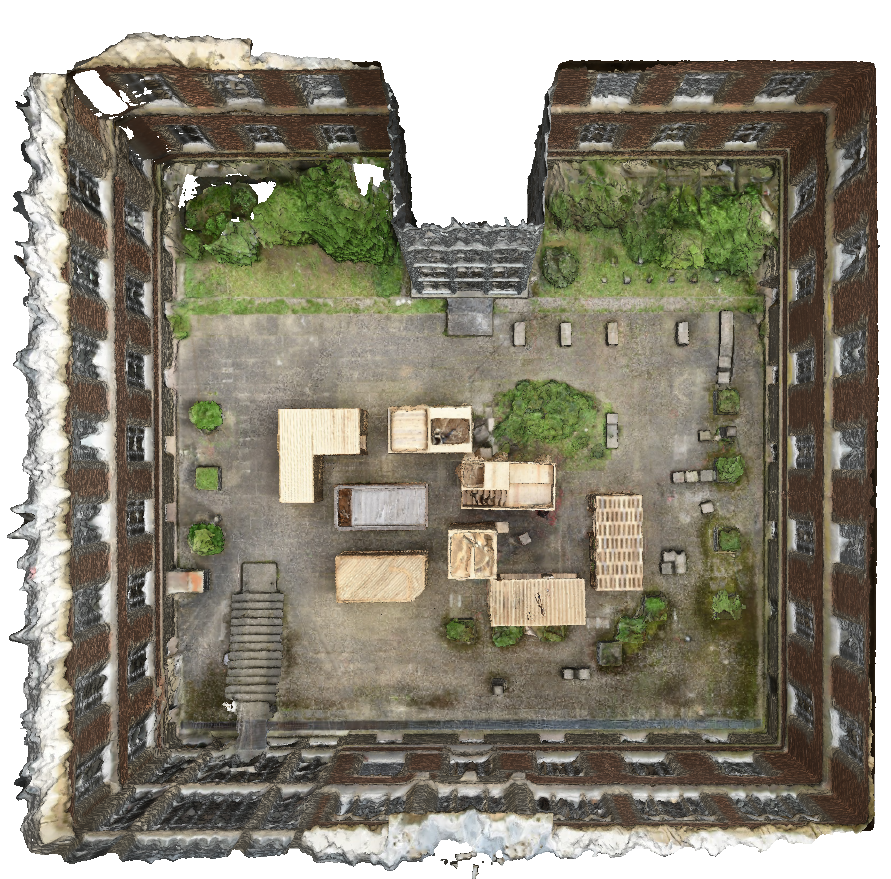
Figure 5. Textured 3D model of the outdoor environment, reconstructed using AgiSoft Photoscan and about 500 high resolution images from a 36 Mpix DSLR camera. The images are also provided in the